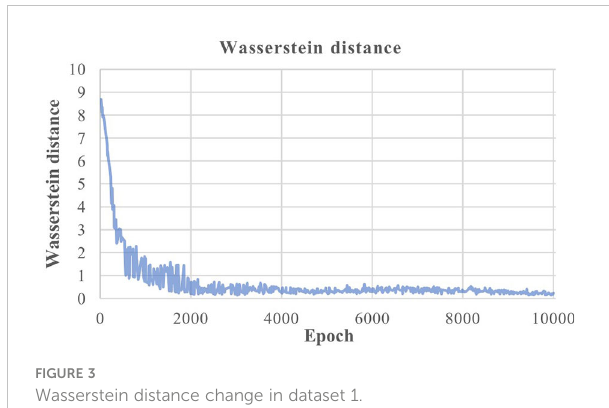
FIGURE 3 Wasserstein distance change in dataset 1.